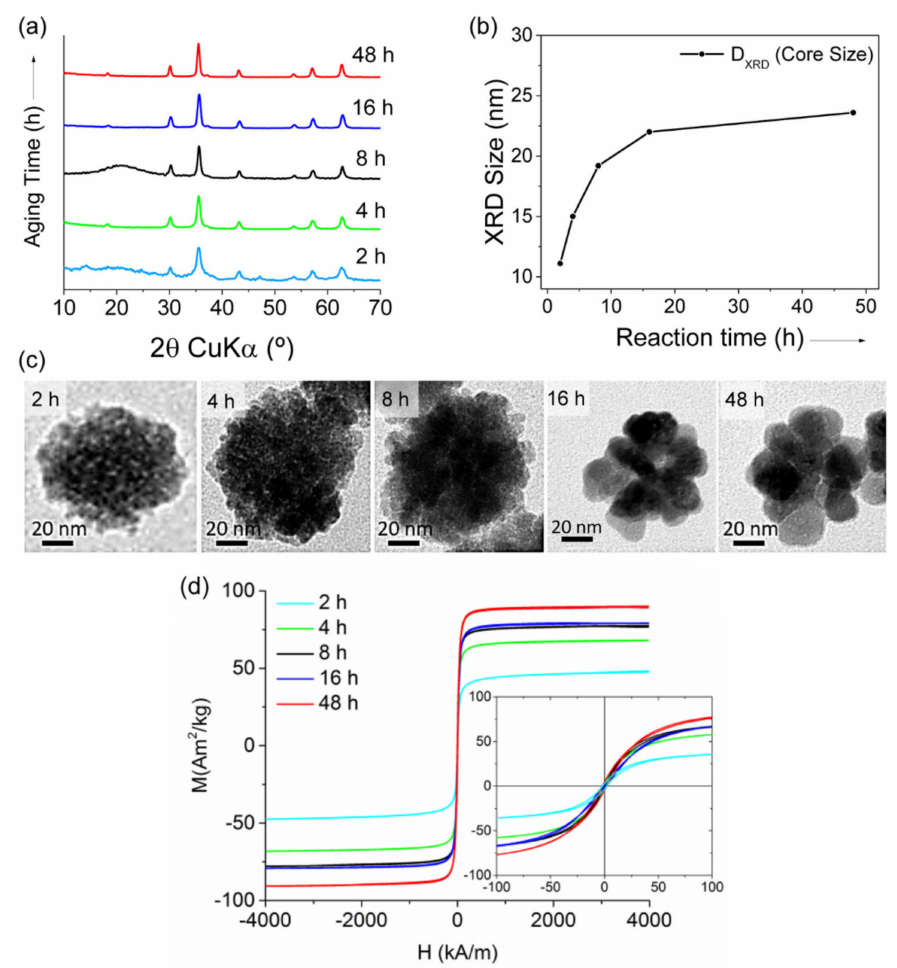
Figure 6. Structure of maghemite MC_NPs at different reaction time (2–48 h) during the synthesis with polyol method: ( a ) X-ray diffraction patterns; ( b ) core size calculated by Scherrer’s equation. ( c ) Representative TEM images. ( d ) Magnetization curves measured on the samples at T = 290 K: M S increased from 48 to 90 Am 2 /kg with prolonging the reaction time, as well as H C (0.5 − 2 kA/m). Adapted with permission from Ref. [158], Copyright 2017 American Chemical Society (further permissions related to the material excerpted should be directed to the